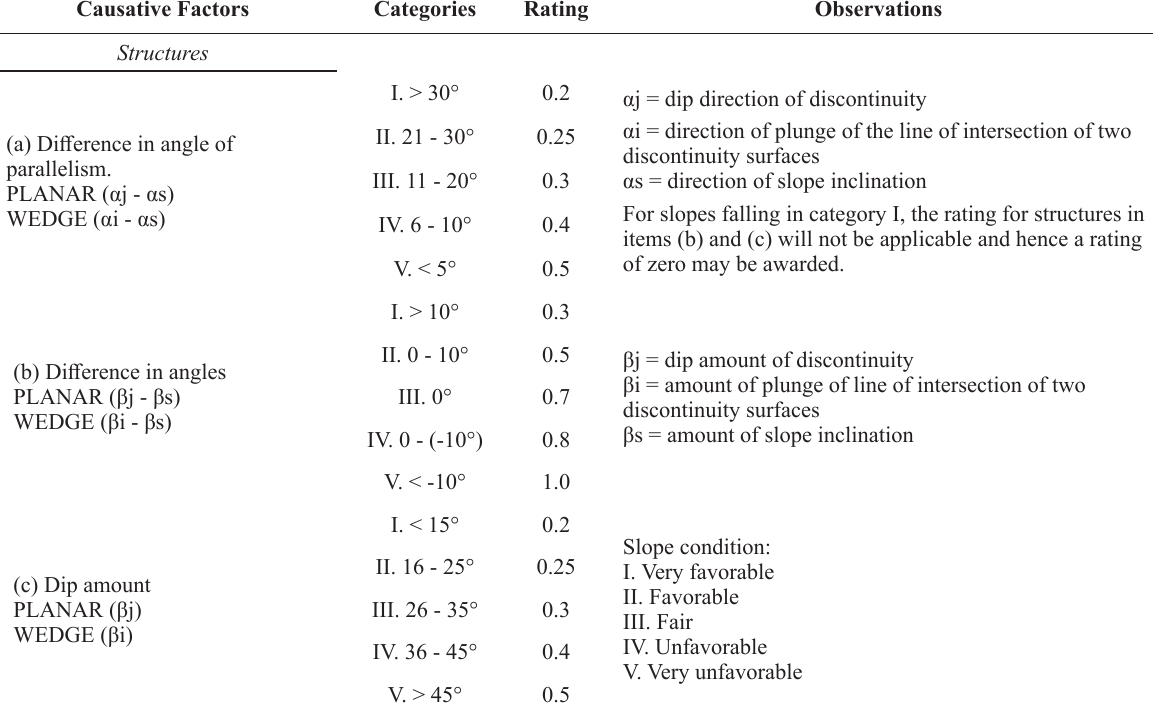
Rating for relationship of parallelism between slope and discontinuity (a), amount of dip/plunge of discontinuity and that of slope inclination (b), and ratings for amount of dip of discontinuity (c) (Anbalagan 1992, Anbalagan et al. 2008).